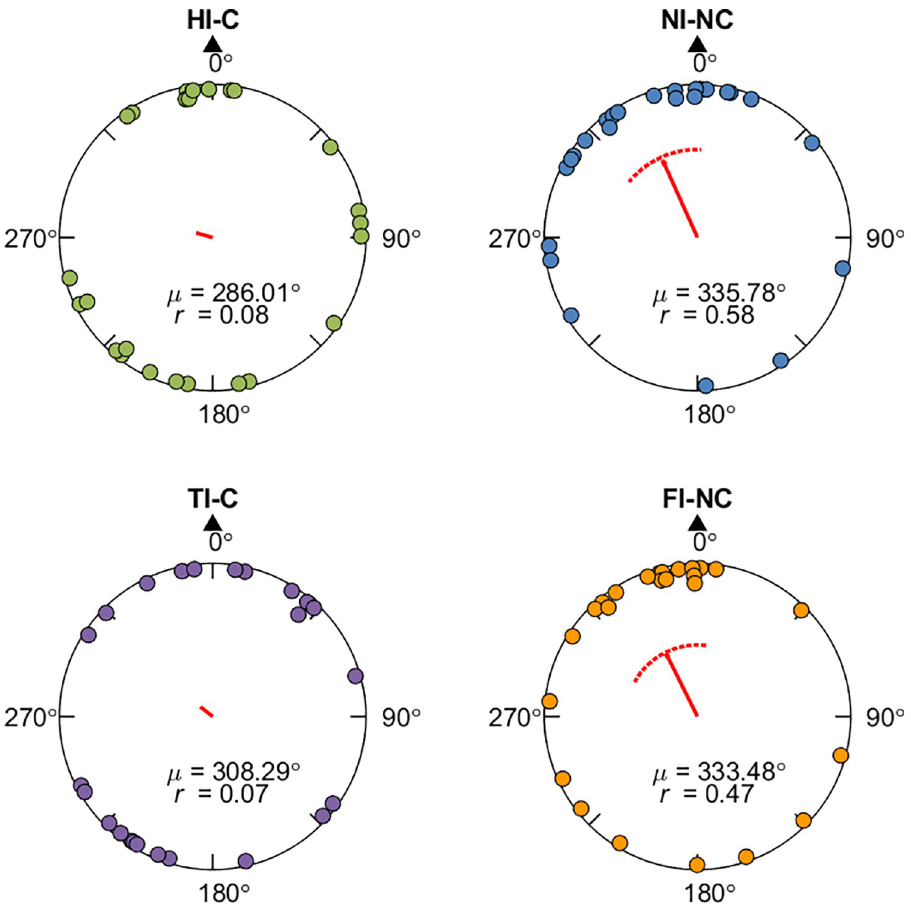
Fig 14. Mean pointing error (AE G ) across paths for each condition in Experiment 4. Abbreviations and legend are the same as in Fig 3.